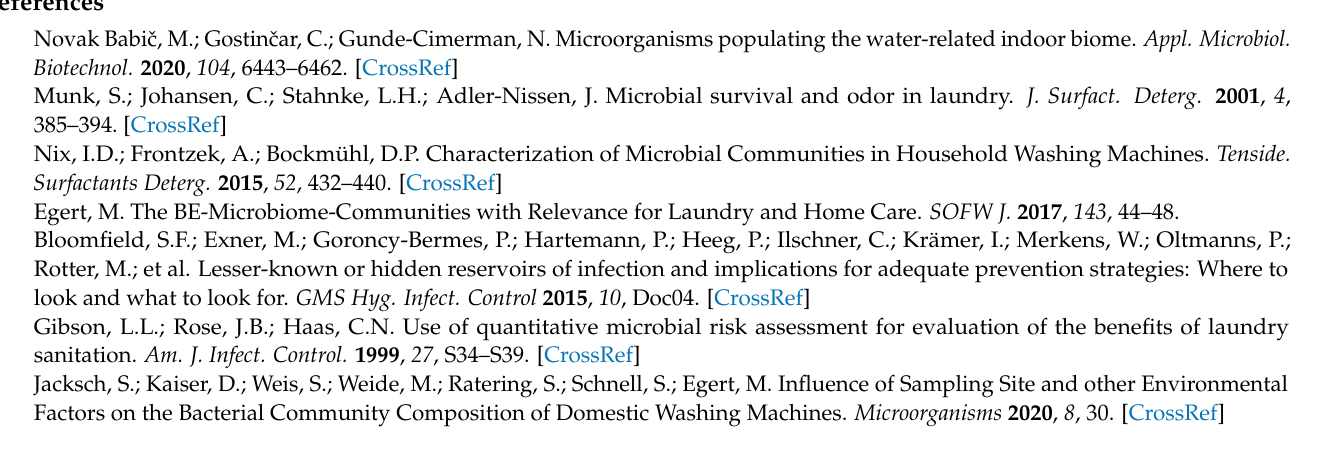
Figure S5: Mean expression versus the log2 fold change plots (MA-plots) of the Spades assembly. Figure S6: Mean expression versus the log2 fold change plots (MA-plots) of the Trinity